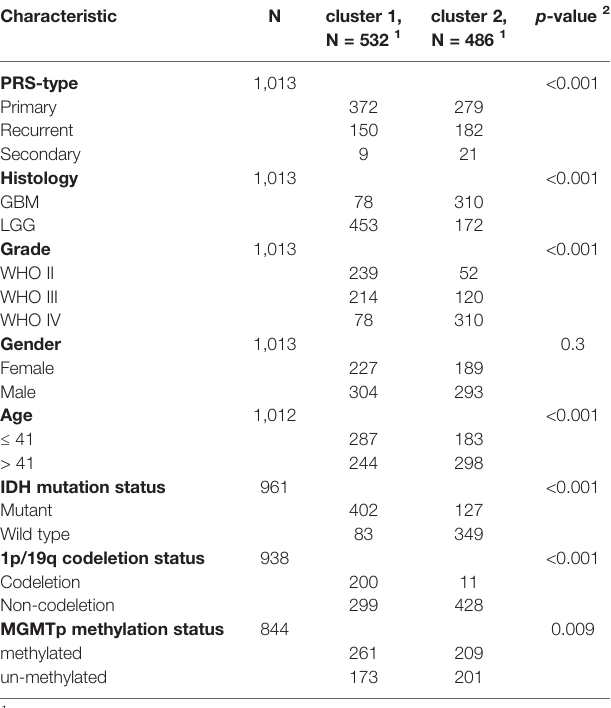
TABLE 1 | Characteristics of patients in cluster 1 and 2 in CGGA